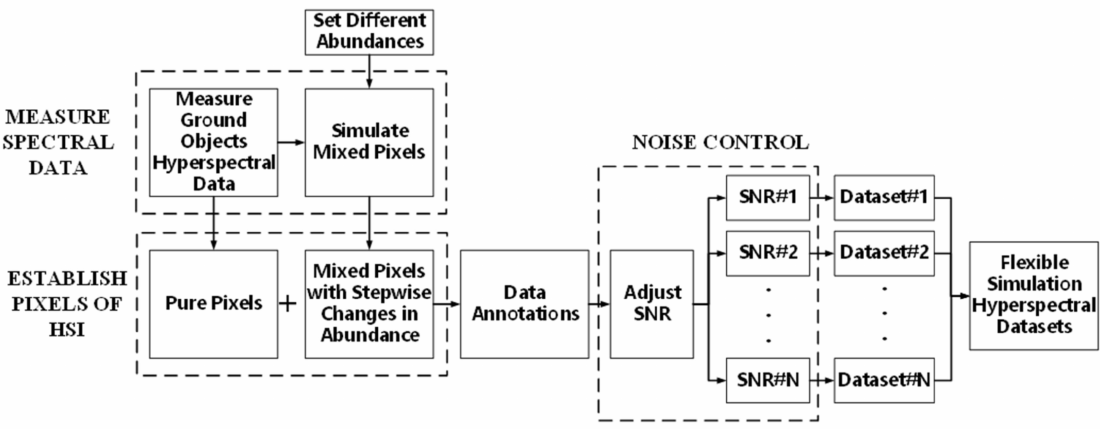
Figure 7. Flexible HSI simulation of ground